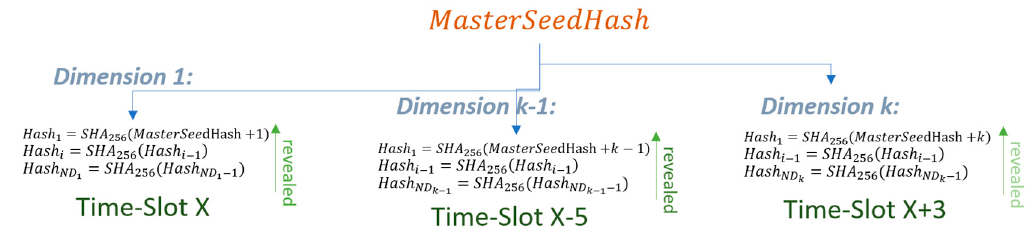
Figure 14. Particular dimensions are independent from each other.